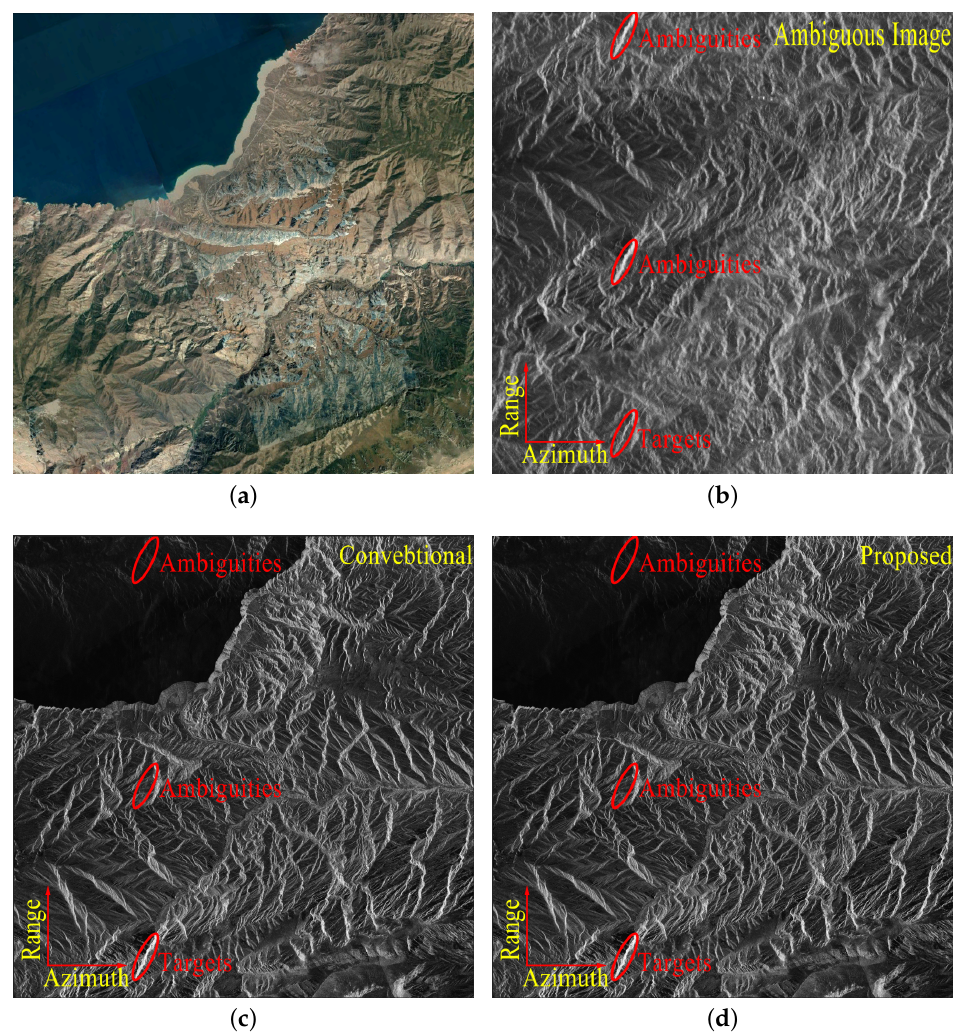
Figure 10. Imaging results of GF-3 dual-channel mode of different calibration methods. ( a ) Corre- sponding optical image. ( b ) Imaging result without channel errors calibration. ( c ) Imaging result using the time-domain correlation method. ( d ) Imaging result using the proposed method.